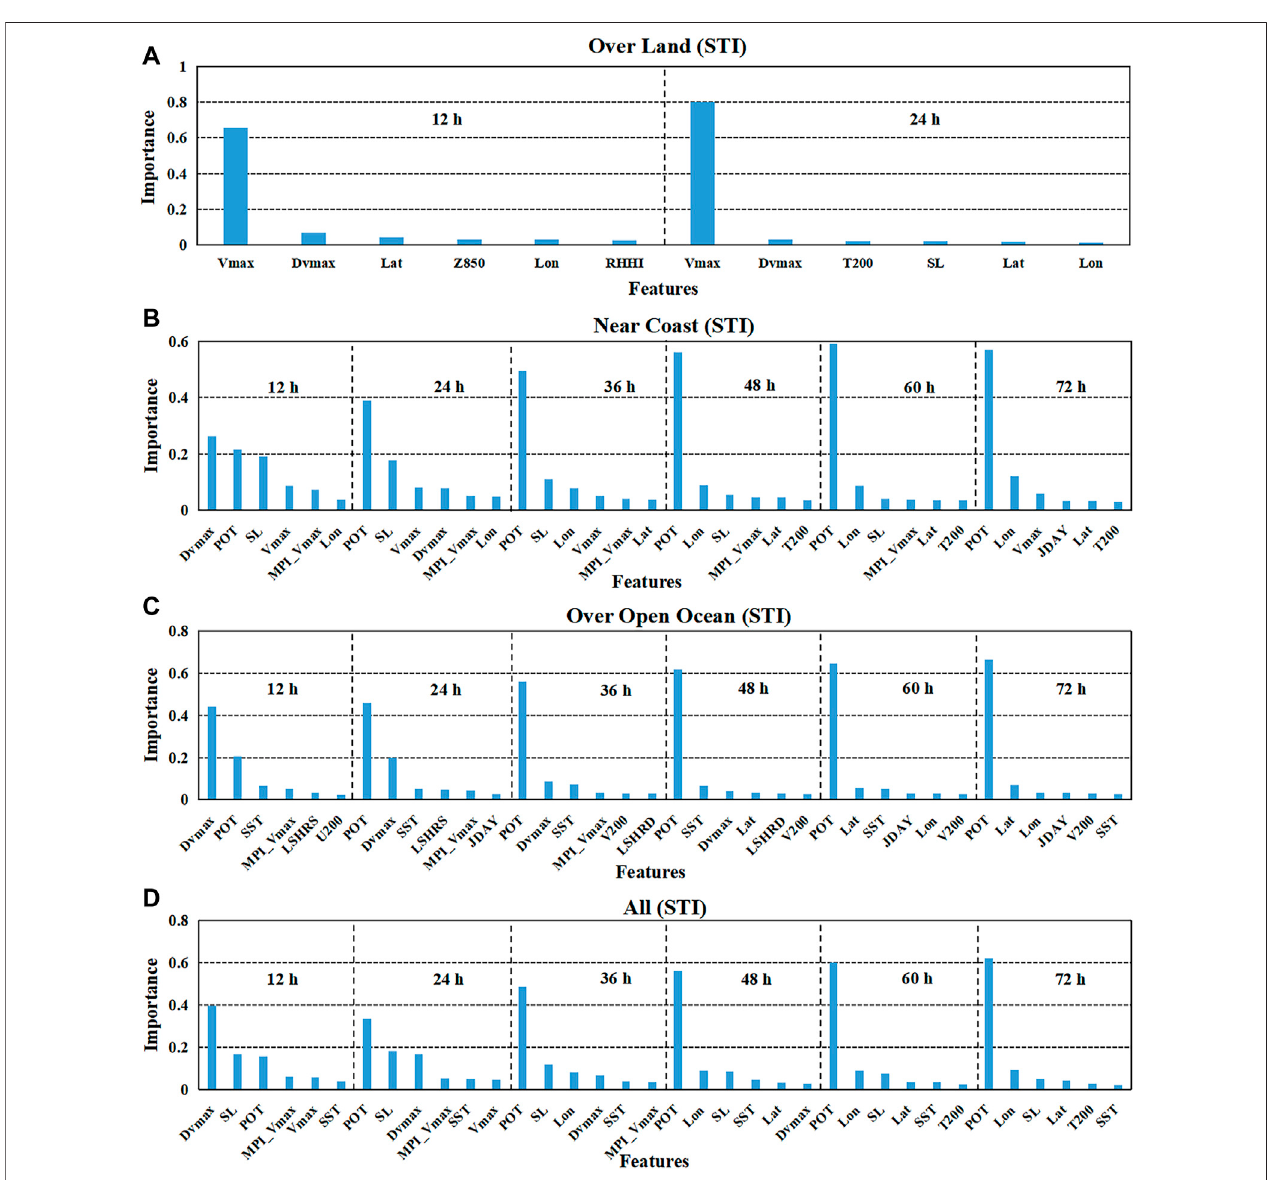
FIGURE 2 | Selection results of the signi fi cant variables for TCs intensity prediction models for the STI datasets by the GBRT method. The vertical axis represents the percentage of the feature importance of the variable in the corresponding prediction model, and the horizontal axis refers to the predictor variable. Only the six most importantvariablesaredisplayedforeachleadtimeforecastingmodel. (A) forTCsamplesoverland; (B) forTCsamplesnearthecoast; (C) forTCsamplesovertheopen ocean; (D) for all TC samples.